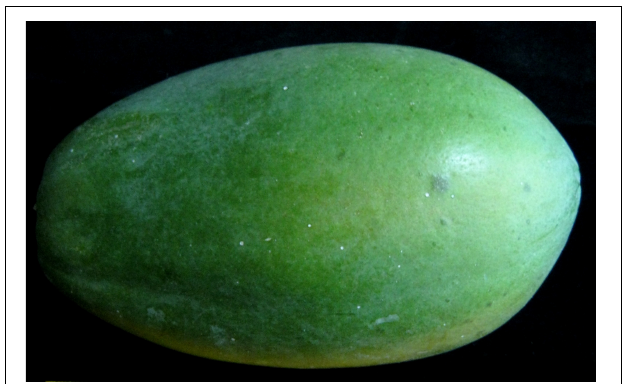
FIGURE 1 | Fruit of Carica papaya L. var.